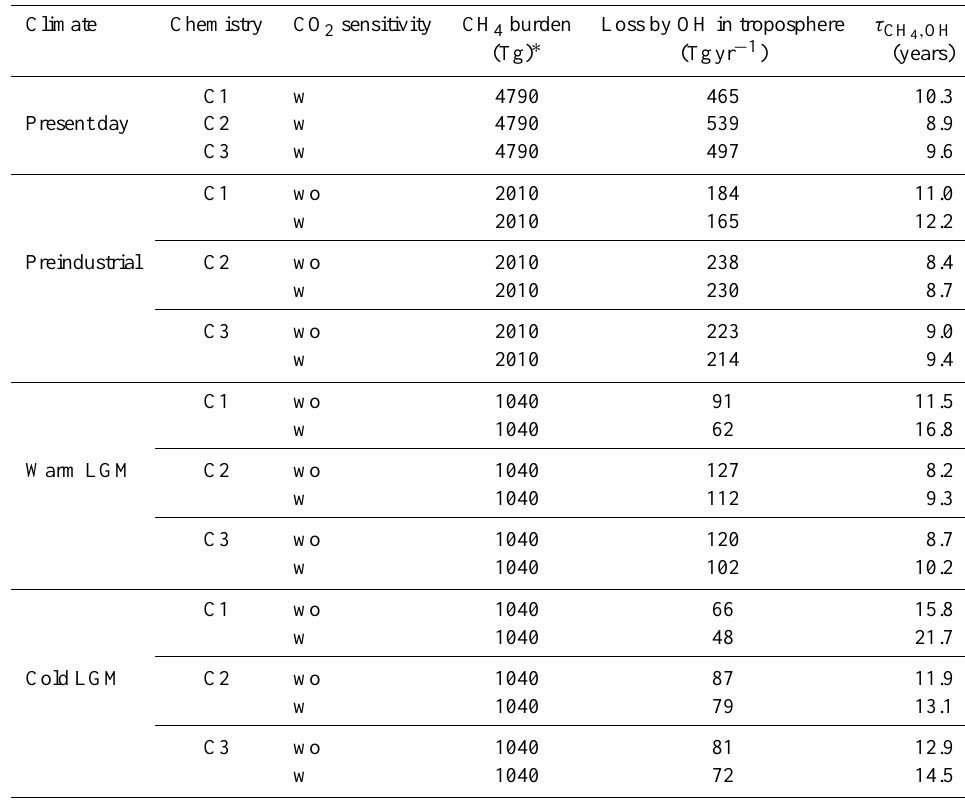
Table 5. Global methane burden and lifetime against tropospheric oxidation by OH ( τ CH